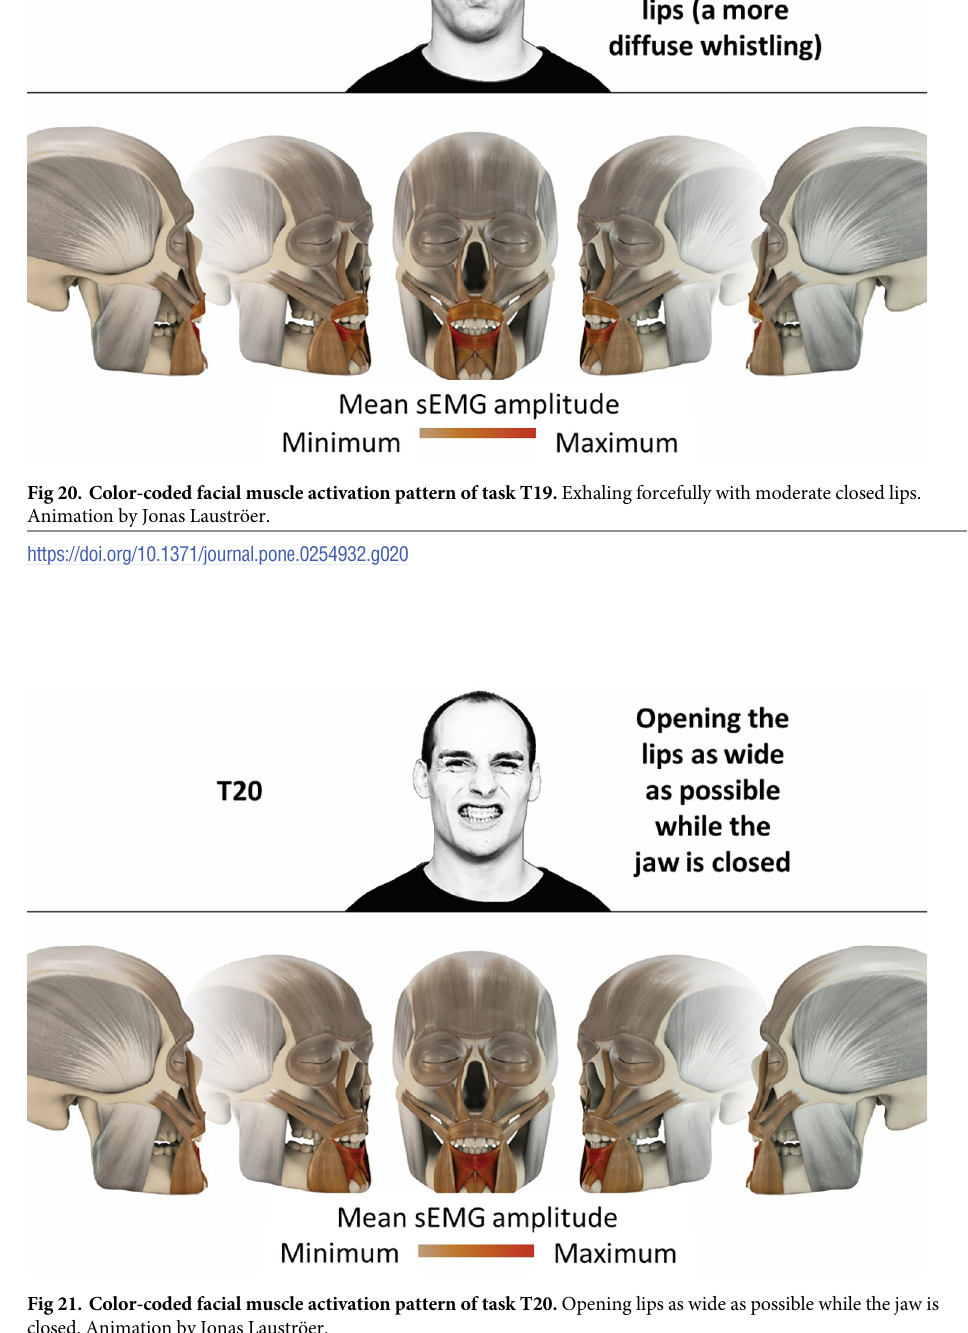
PLOS ONE | https://doi.org/10.1371/journal.pone.0254932 July 19,